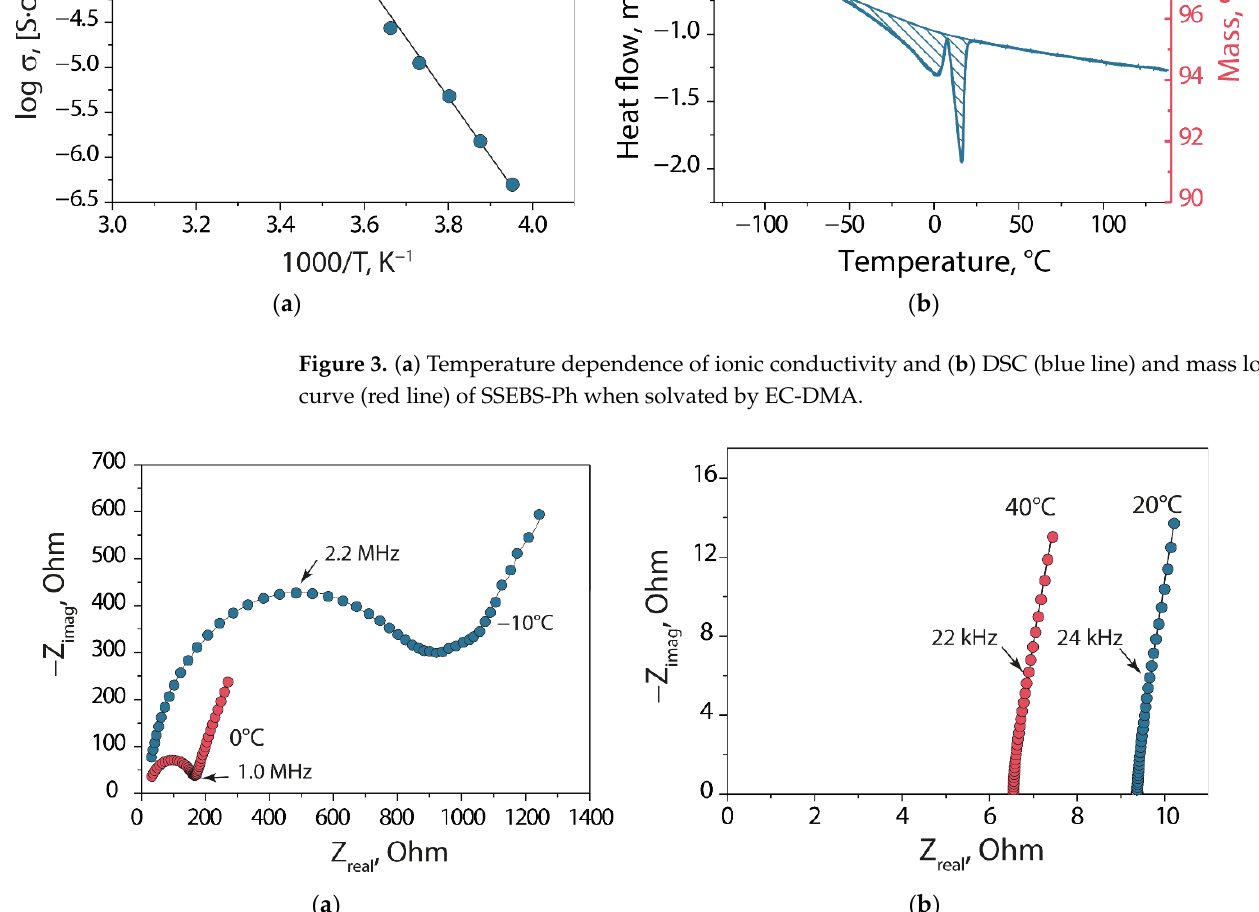
Figure 5. The chronoamperometry curve at a potential of 0.01 V and impedance spectra before and after polarization with DC of the Li|SSEBS-Ph-EC-DMA|Li cell. According to linear sweep voltammetry (Figure 6a), there are no anodic peaks for the electrolyte. A sharp increase in the current density corresponding to the electrolyte reduc- tion is detected at only above 4.1 V vs. Li/Li + . According to cyclic voltammetry in the po- tential range of 2.5− 4.1 V (when corresponding to the operating range of batteries with a LFP cathode), when there is an increasing cycle number then there follows a gradual de- crease in the current in regard to the high-potential region (Figure 6b), which indicates an increase in the stability of the electrolyte during cycling. According to the data of the galvanostatic cycling of a symmetrical Li|Li cell, at a current density of 0.1 mA∙cm −2 with a cut-off capacity of 0.05 mAh∙cm −2 , the electrolyte is